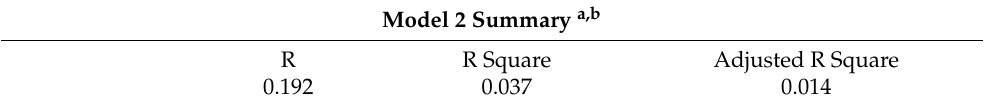
Table 2. Linear autoregression with exogenous factor.